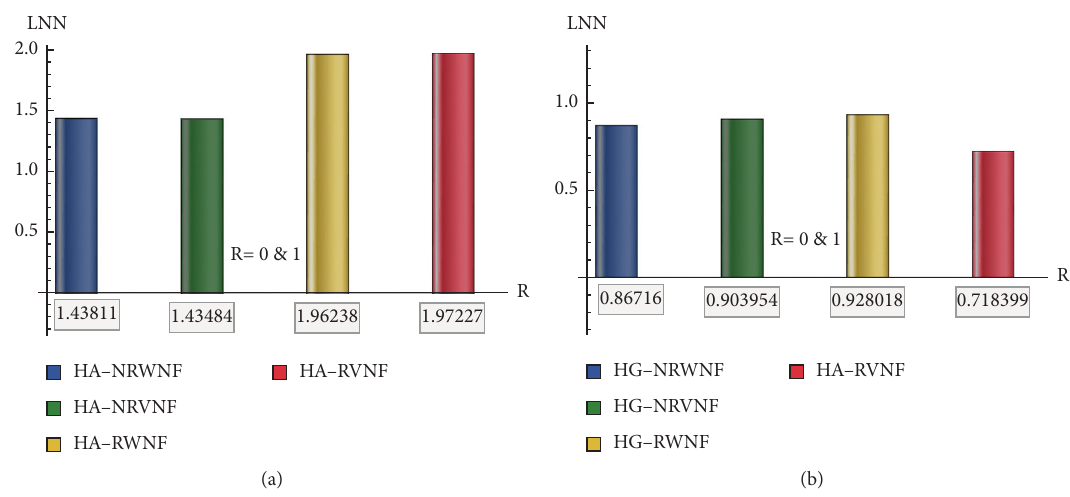
Figure 11: The local Nusselt number on various combinations of Hg and R of a CCHF flow of WNF and